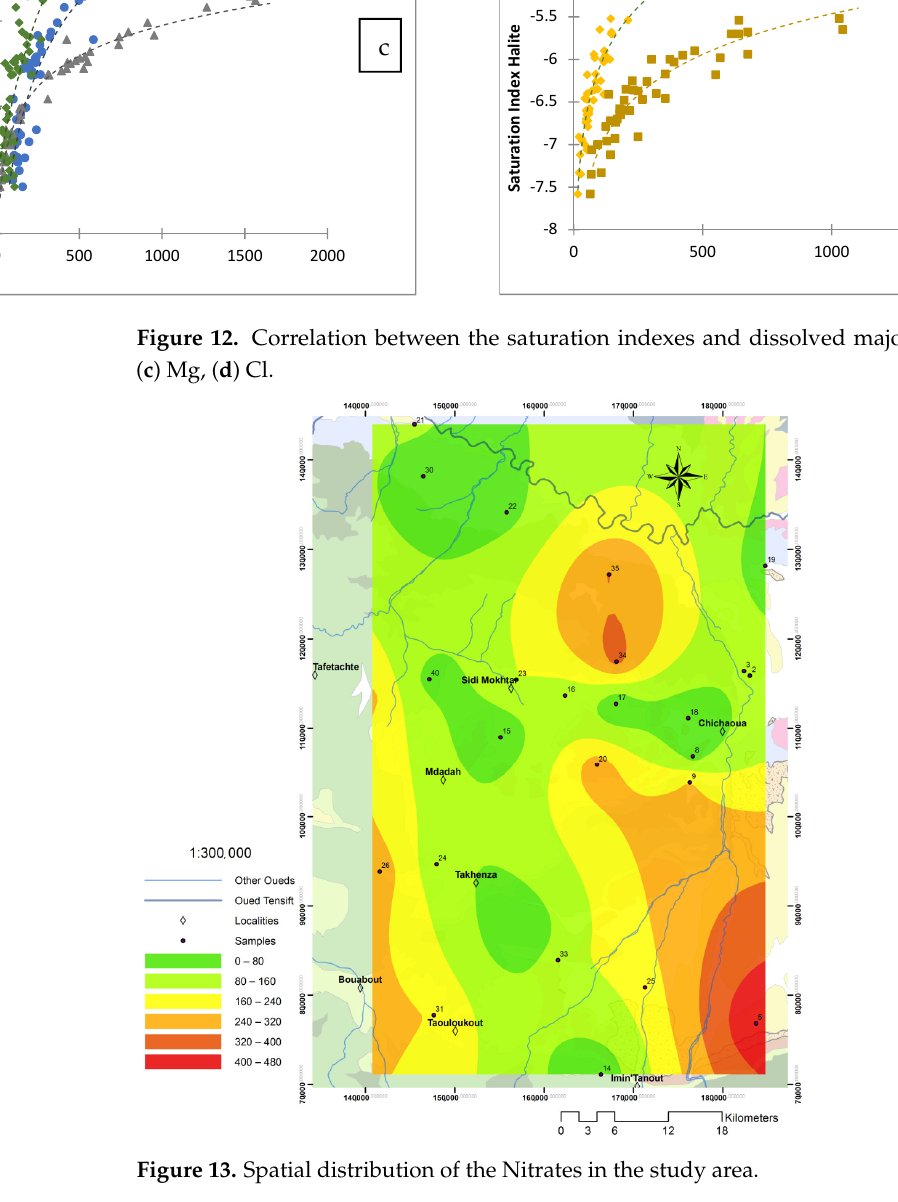
Figure 12. Correlation between the saturation indexes and dissolved major ions ( a ) Mg, ( b ) Ca, ( c ) Mg, ( d ) Cl.